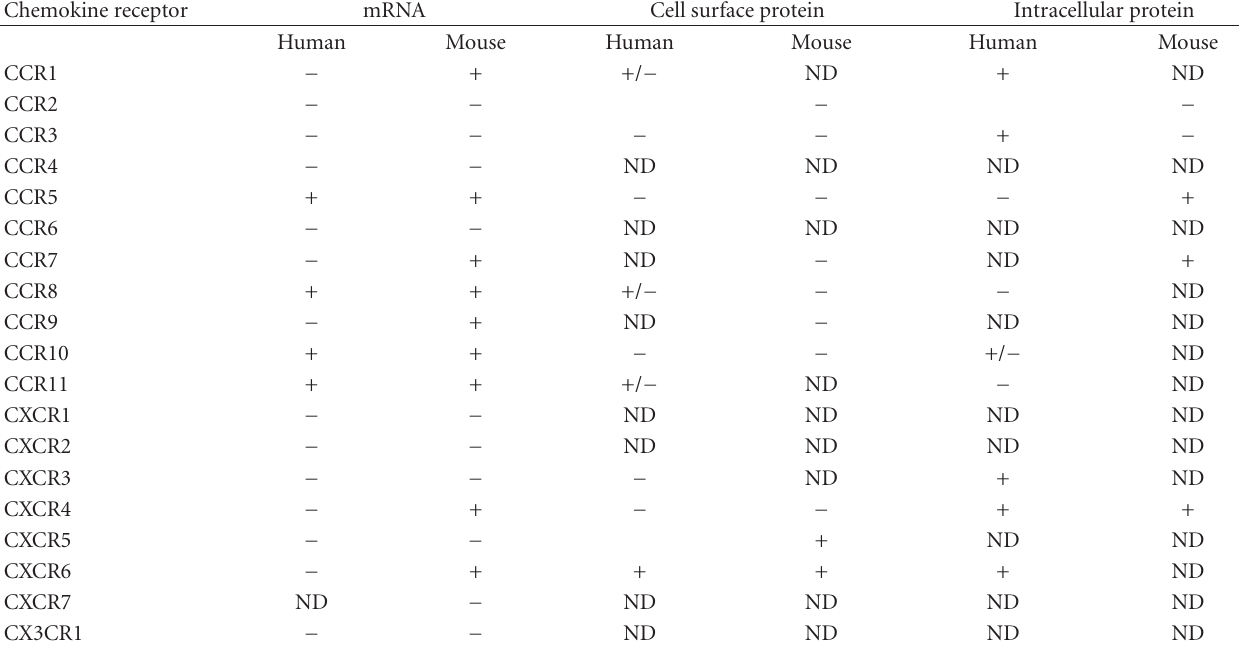
Table 2: Expression of chemokine receptor mRNA by human and murine bone marrow derived MSC as determined by microarray or qRT-PCR and flow